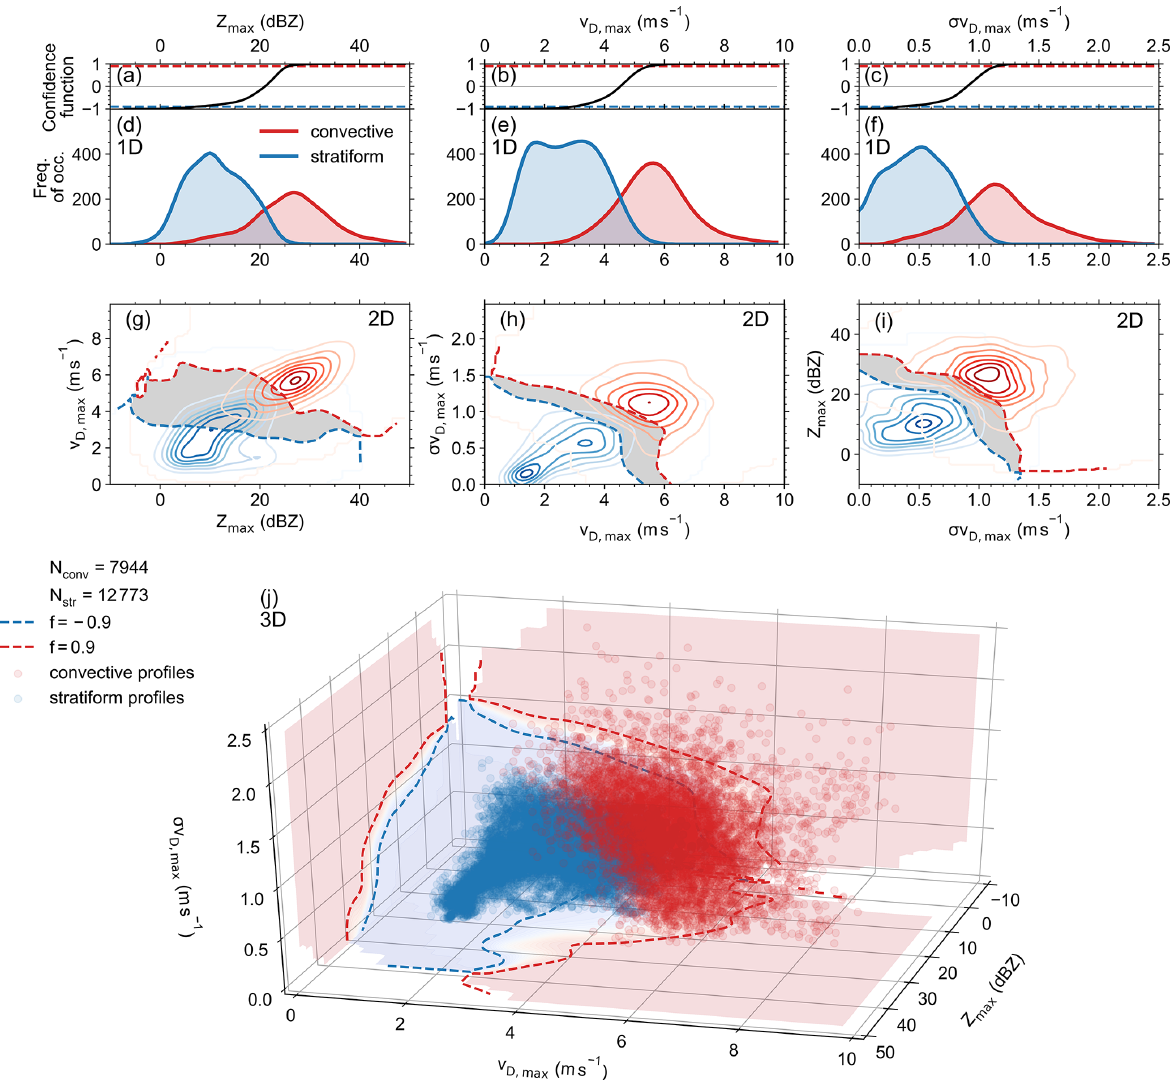
Figure 4. Overview of the one-dimensional (1D: d, e, f ), two-dimensional (2D: g, h, i ), and three-dimensional (3D: j ) probability density functions for the maximum radar reflectivity Z max per profile (d) , the maximum of the observed Doppler velocity v D , max per profile (e) , the maximum of the temporal standard deviation of the observed Doppler velocity σv D , max per profile (f) , and each 2D combination of these three variables (g–i) . Panel (j) shows the 3D scatterplot of the three variables with the contour of the corresponding confidence values in each plane. Panels (a) – (c) show the confidence function of the corresponding 1D distributions. The dashed lines represent the thresholds of a confident classification with values beyond − 0.9 and 0.9, whereas values in between are indicated by a grey area (g–i) . Stratiform or convective profiles are indicated by blue or red colors and by low or high values of the confidence functions,